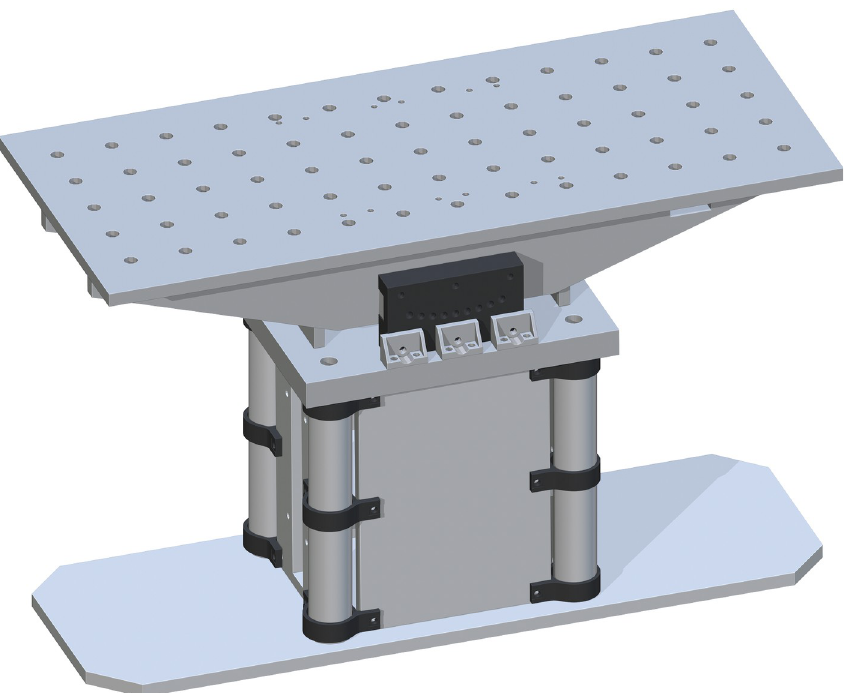
Fig 13. Completing the Table Top assembly by adding the Table Top.